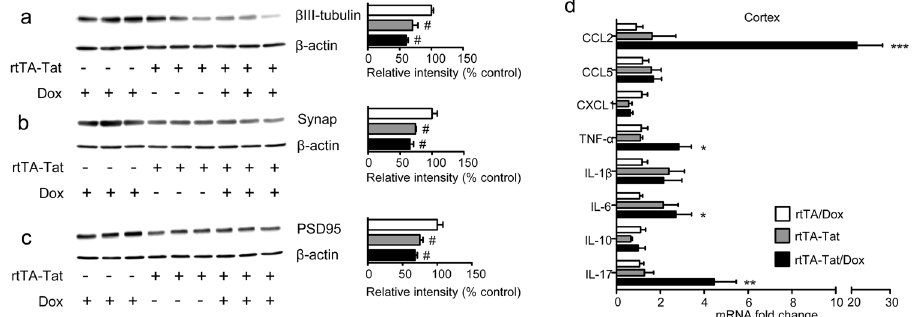
Figure 2. Evidence for axonal and synaptic damage in doxycycline naïve rtTA-Tat mice. Immunoblots and density quantitation of ( a ) the axonal marker β III-tubulin, ( b ) the presynaptic marker Synaptophysin, and ( c ) the postsynaptic marker PSD95 in cortex of 11–12 month old mice with the indicated genotype and treatment condition. ( d ) qRT-PCR analysis showing expression of the indicated cytokines in cortex of 11–12 month old mice with the indicated genotype and treatment condition. Data are expressed as mean ± SEM. N = 3 mice per condition for western blots, and n = 6–7 per group for qRT-PCR. *** p < 0.001, ** p < 0.01, * p < 0.05, and # p < 0.05 compared to rtTA control